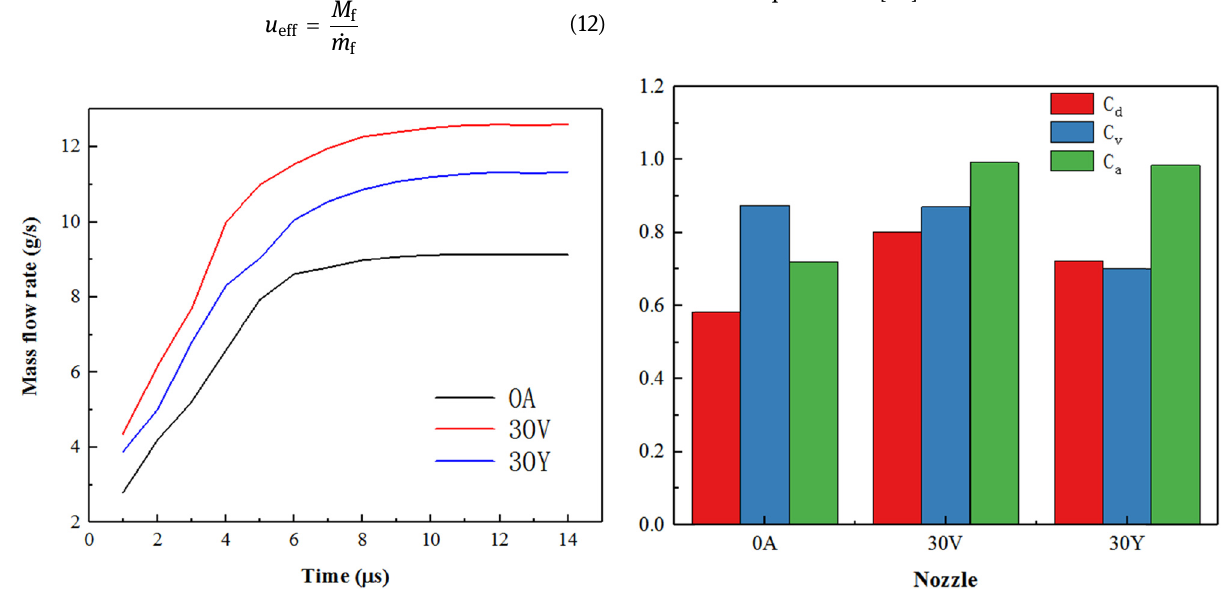
Figure 5: Mass fl ow rates of nozzles. Figure 6: Velocity and area coe ffi cients for nozzles 0A, 30V, and